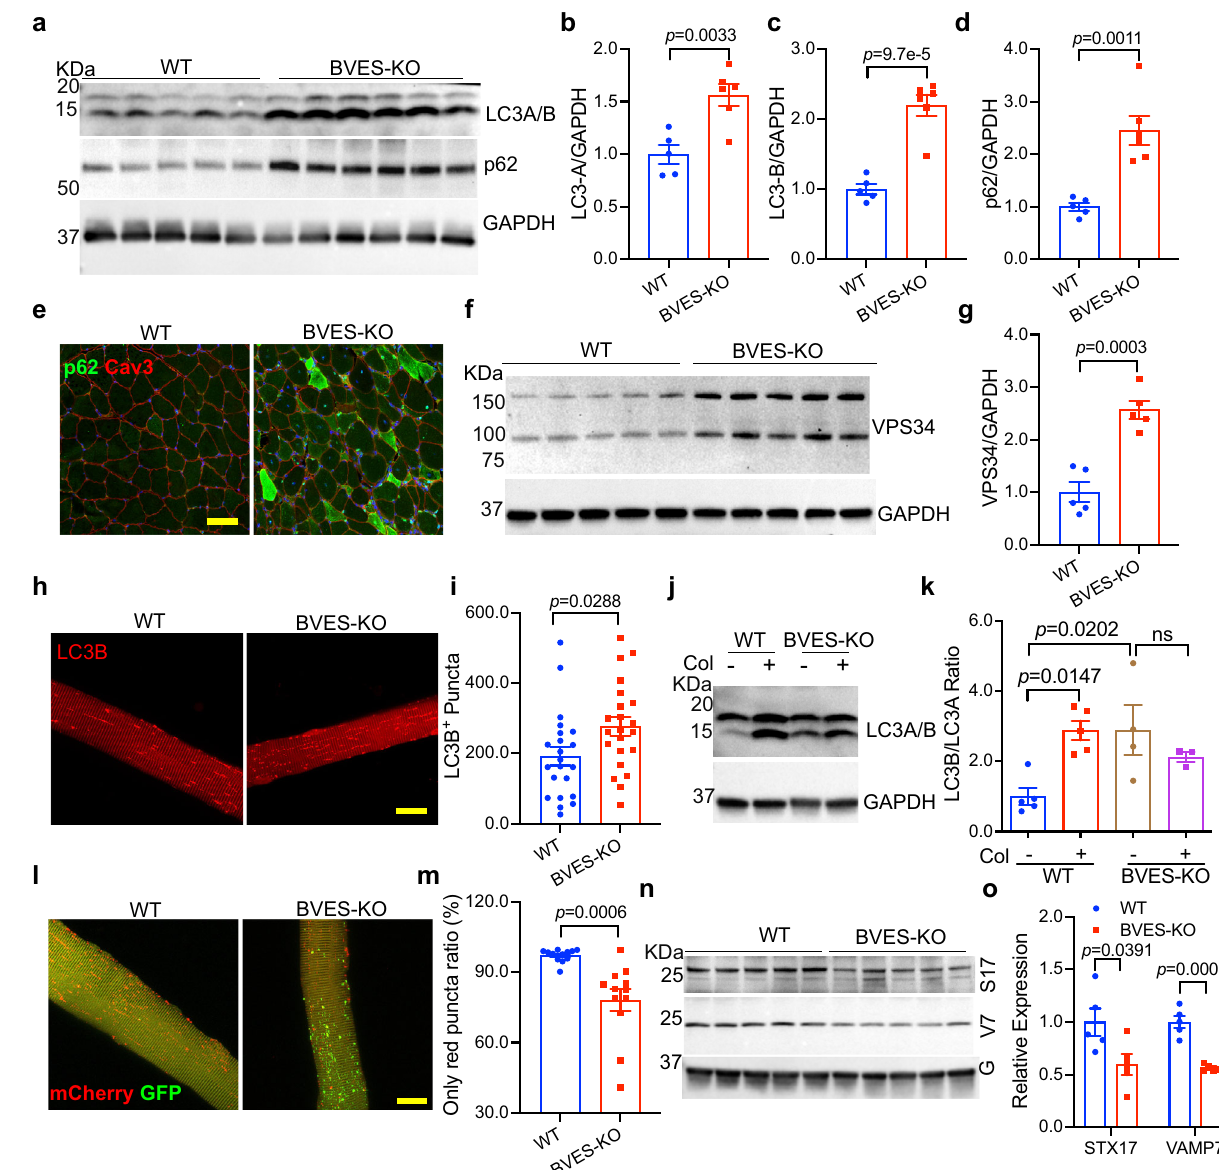
Fig. 6 | BVES Disruption suppresses the autophagic execution. All animal experiments were performed in WT and BVES-KO male mice with the C57BL/6N geneticbackground. a – d Westernblot( a )ofautophagicmarkersandquanti fi cation of LC3A( b ),LC3B( c ) and p62 ( d ) normalized to GAPDH in totalGA muscleextracts from 8-month-old WT ( n =5) and BVES-KO ( n =6) male mice. e The p62 and Cav3 immunostaining of GA muscles from 4-month-old WT and BVES-KO male mice. ( n =5 biologically independent experiments). Scale bar: 100 µ m. f , g , Western blot ( f )andquanti fi cation( g )ofVPS34intotalGAmuscleextractsfrom8-month-oldWT ( n =5) and BVES-KO ( n =5) male mice. h , i Live cell imaging ( h ) of RFP-LC3B and quanti fi cation( i )ofLC3BpunctainFDBmuscle fi bersfrom8-month-oldWT( n =22 fi bers from 3 mice) and BVES-KO ( n =22 fi bers from 3 mice) male mice at 5 days after electroporation with pCMV-RFP-LC3B. j , k Western blot ( j ) and quanti fi cation